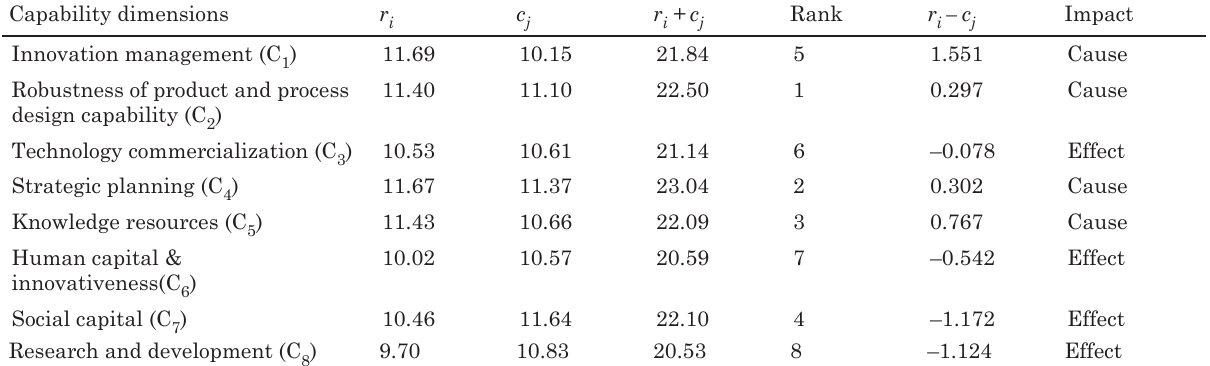
Table 9. Final results for the